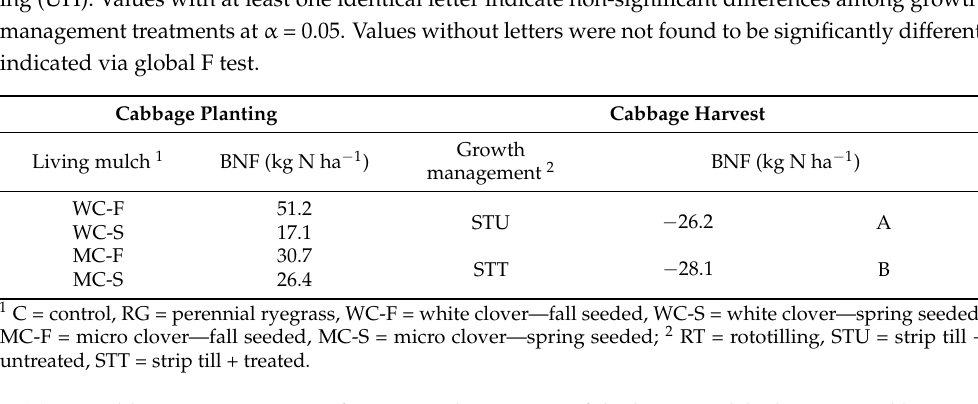
Table 6. Yield, N concentration, C/N ratio and N content of the living mulch aboveground biomass of both locations shortly before cabbage planting. Values with at least one identical letter indicate non-significant differences among treatments of LM species at α = 0.05. Values without letters were not found to be significantly different indicated via global F